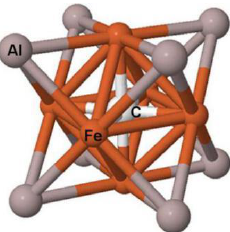
Figure 1. Conventional cell of κ -Fe 3 AlC carbide. Please note that white balls represent carbon atoms, grey balls represent aluminum atoms, and orange balls represent iron atoms. (Reprinted with permission from [21], copyright Elsevier, 2008).